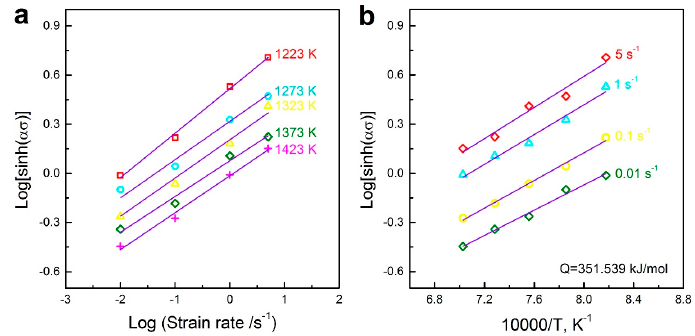
Figure 5. Correlation between ( a ) log[sinh( ασ )] vs. log (cid:2013) (cid:4662) at different temperatures and ( b ) log[sinh( ασ )] vs. 10,000/ T at different strain rates.